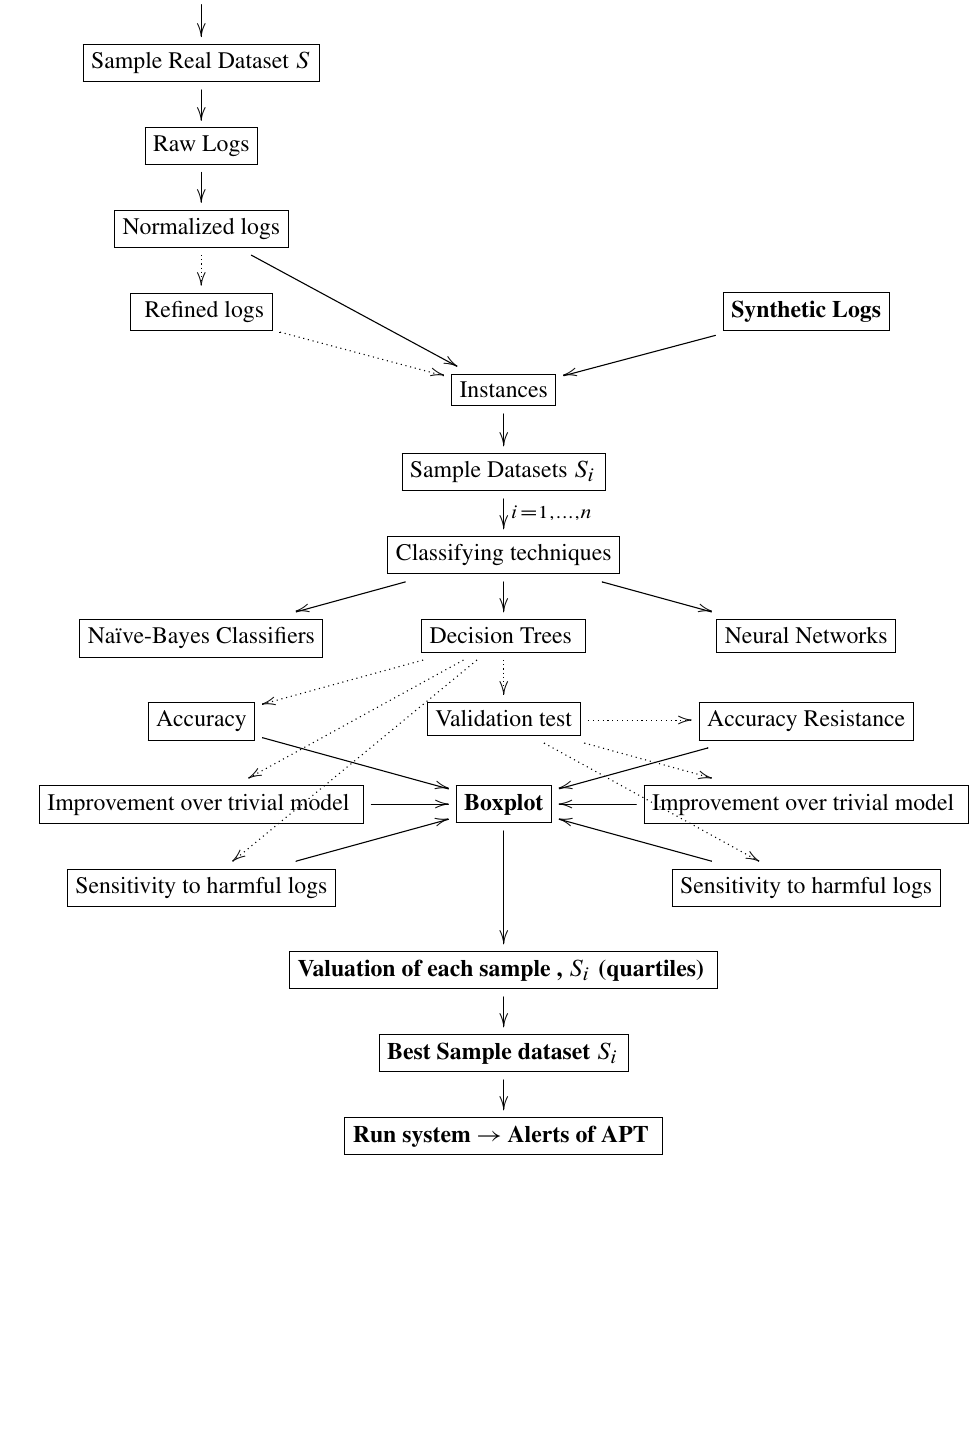
Fig. 1. Structure of the process to generate an APT detector